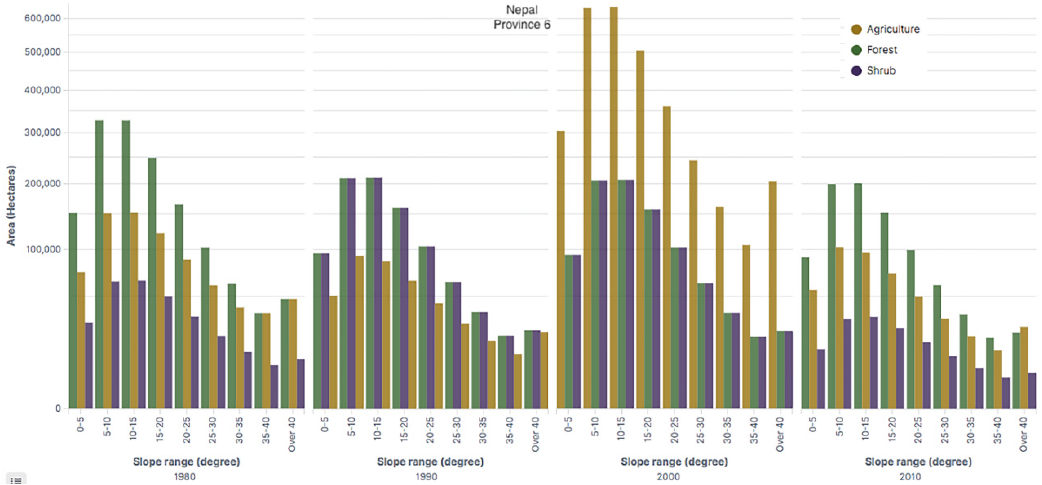
Figure 17. Province 6: forest, shrubland, and agricultural areas of Nepal by 9 elevation classes for 1980, 1990, 2000, and 2010. Table 12: Province 6: land use as a percentage of total area of forest, shrubland, and agriculture for 1980, 1990. 2000, and 2010 for entire Nepal. ((Individual land-use area for a slope class/sum of forest + shrubland + agriculture) * 100).